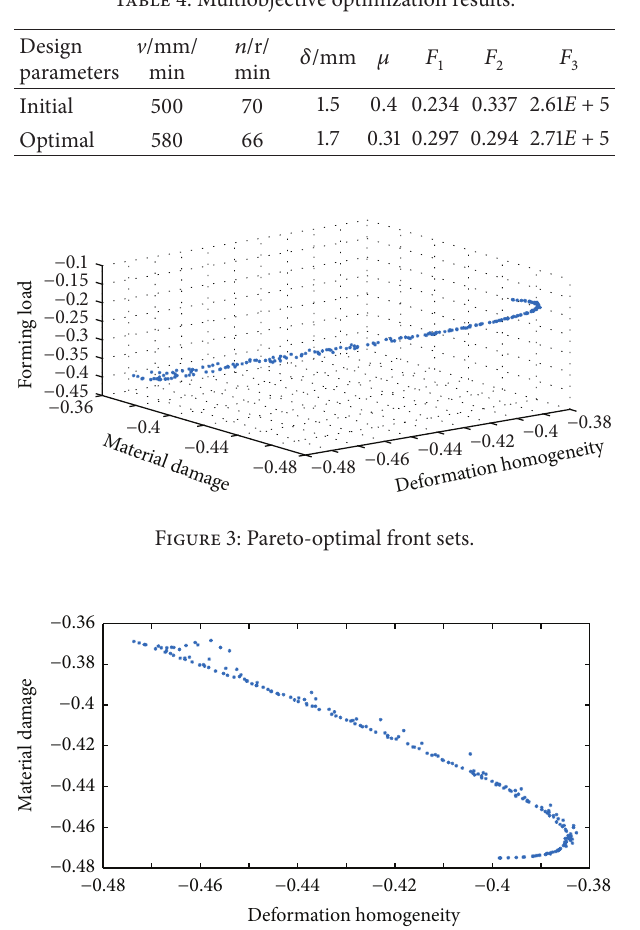
Figure 4: Deformation homogeneity and material damage.